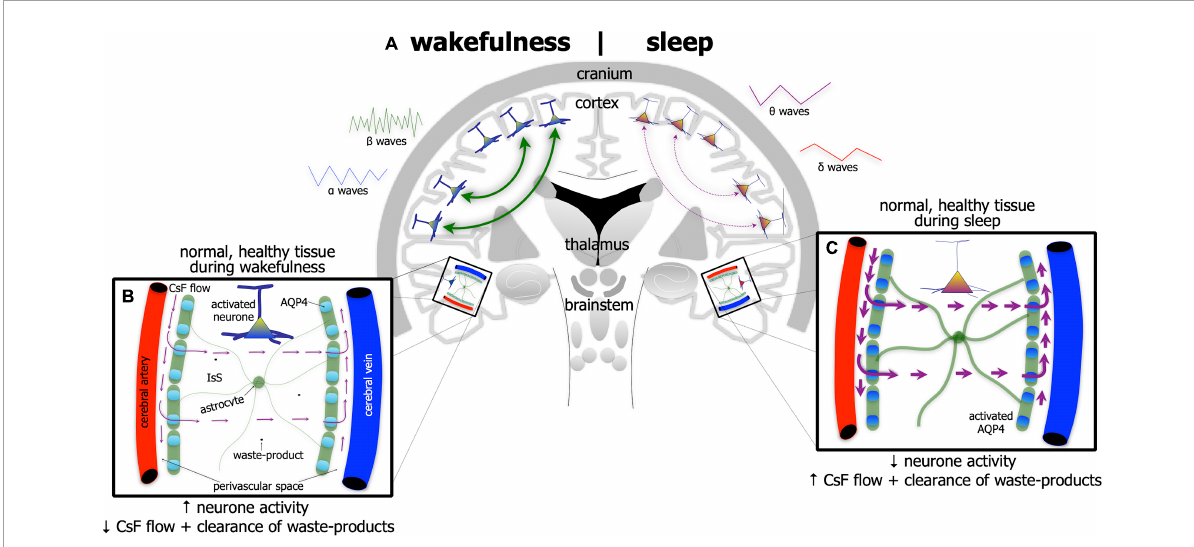
FIGURE3 Schematic diagram of the brain (A) highlighting the glymphatic system – the house-keeper of the brain – in wakefulness [left side of brain schematic in panel (A) ; and inset (B) ] and in sleep [right side of brain schematic in panel (A) ; and inset (C) ]. Glymphatic activity is greater during sleep [represented by thicker astrocyte processes and thicker arrows of cerebrospinal fluid (CsF) flow in panel (C) ] than in wakefulness (B) . Its activity is correlated with changes in brain wave-forms in the different arousal states; it increases with the onset and predominance of δ and θ waves, characteristic of slow-wave [right side of panel (A) ] and reduces with onset and predominance of α and β waves, characteristic of wakefulness [left side of panel (A) ]. The glymphatic system works with CsF flowing into perivascular spaces around the arteries and then into the interstitial space (IsS) within the brain via aquaporin-4 (AQP4) in astrocytic end-feet. AQP4 is more active during sleep (C) than in wakefulness (B) . This process drives the drainage of excess fluid and waste into perivascular spaces around the